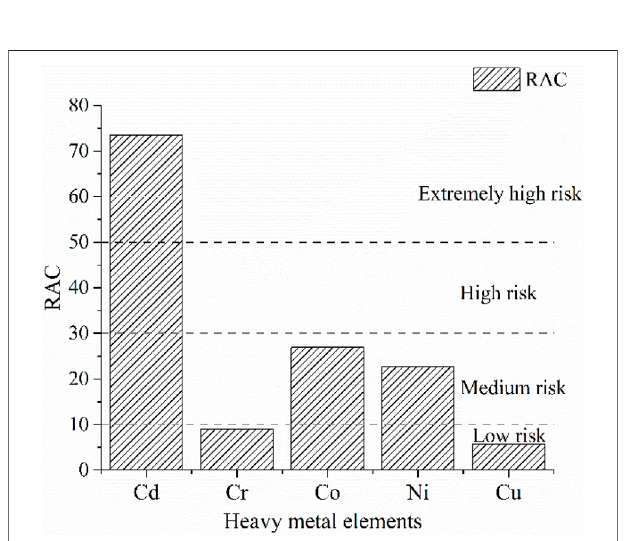
FIGURE 7 | Risk assessment grade of heavy metals.